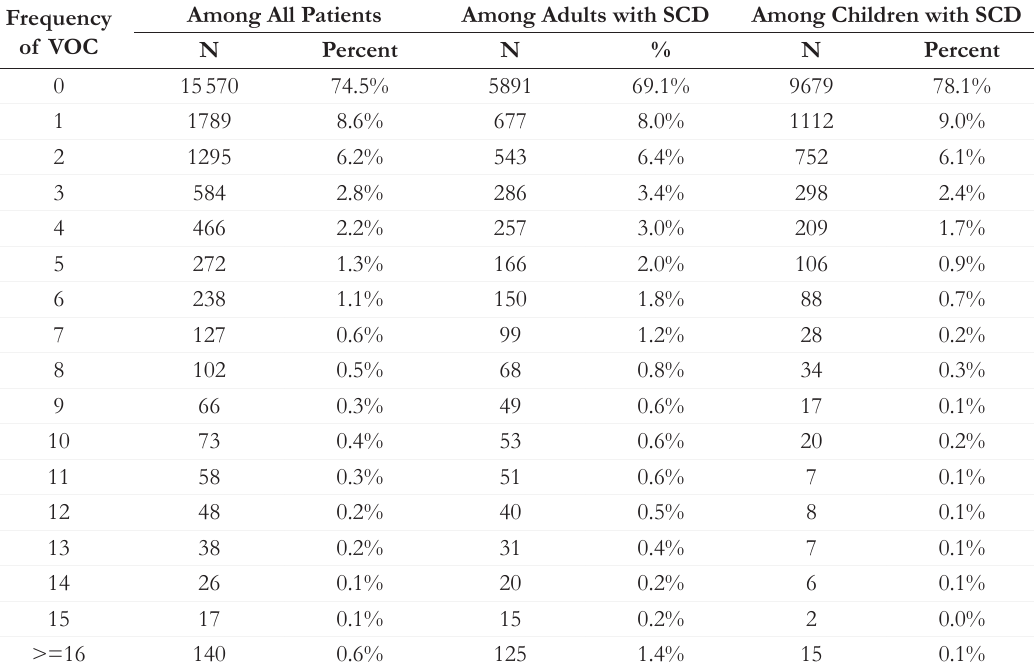
Table 3. Frequency of VOC during One-year among Medicaid Population Frequency of VOC